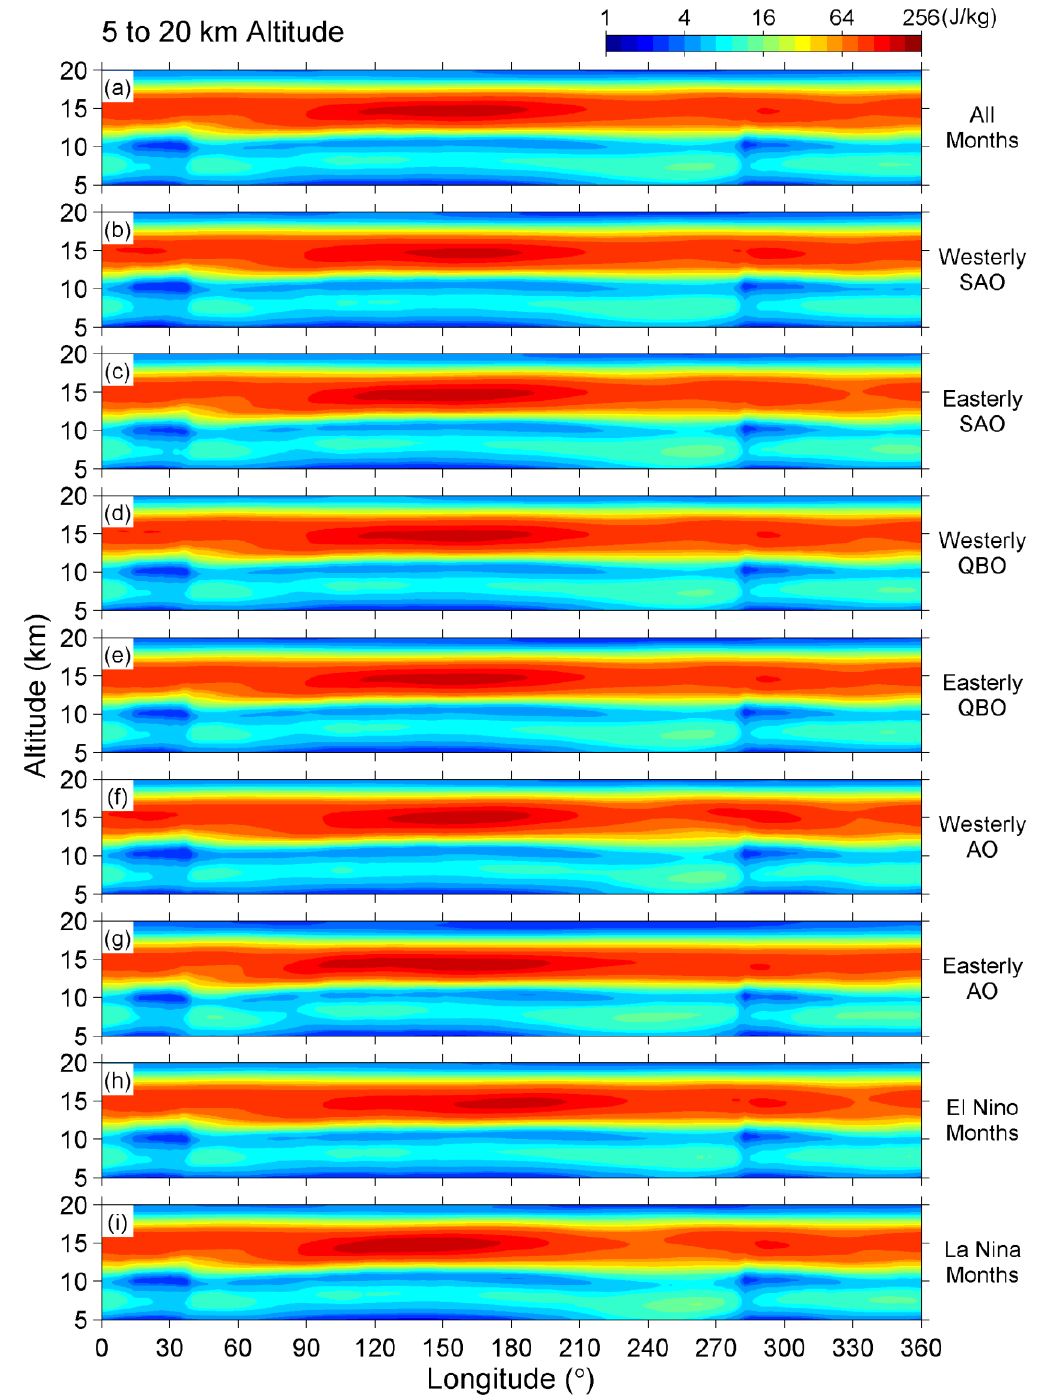
Figure 7. The time-averaged E P at 5 – 20 km altitude under different conditions. ( a ) All months in the 41-year studying period; ( b,c ) westerly and easterly phases of the semiannual oscillation (SAO); ( d,e ) westerly and easterly phases of the quasi-biennial oscillation (QBO); ( f,g ) westerly and easterly phases of the annual oscillation (AO); ( h,i ) El Niño and La Niña episodes.